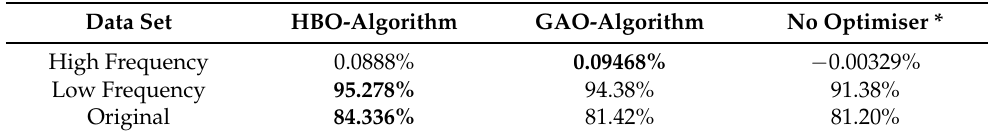
Table 3. Comparison between Effect of Data Decomposition and Effect of Tuning Algorithms using Model Fitness. Data Set HBO-Algorithm GAO-Algorithm No Optimiser * High Frequency 0.0888% 0.09468% − 0.00329% Low Frequency 95.278% 94.38% 91.38% Original 84.336% 81.42%